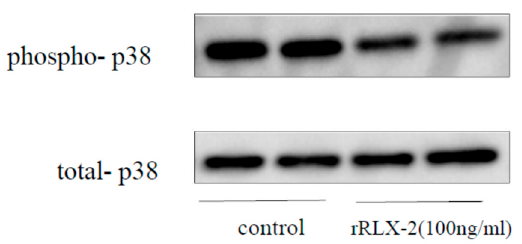
Figure 4. p38MAPK phosphorylation with relaxin-2 (RLX-2) treatment in endometriotic stromal cells (ESCs). ESCs were incubated with RLX-2 for 24 h. Cell lysates were prepared and assayed for phosphorylated p38 MAPK (phospho-p38) or total p38 MAPK (total-p38) by Western blotting. The